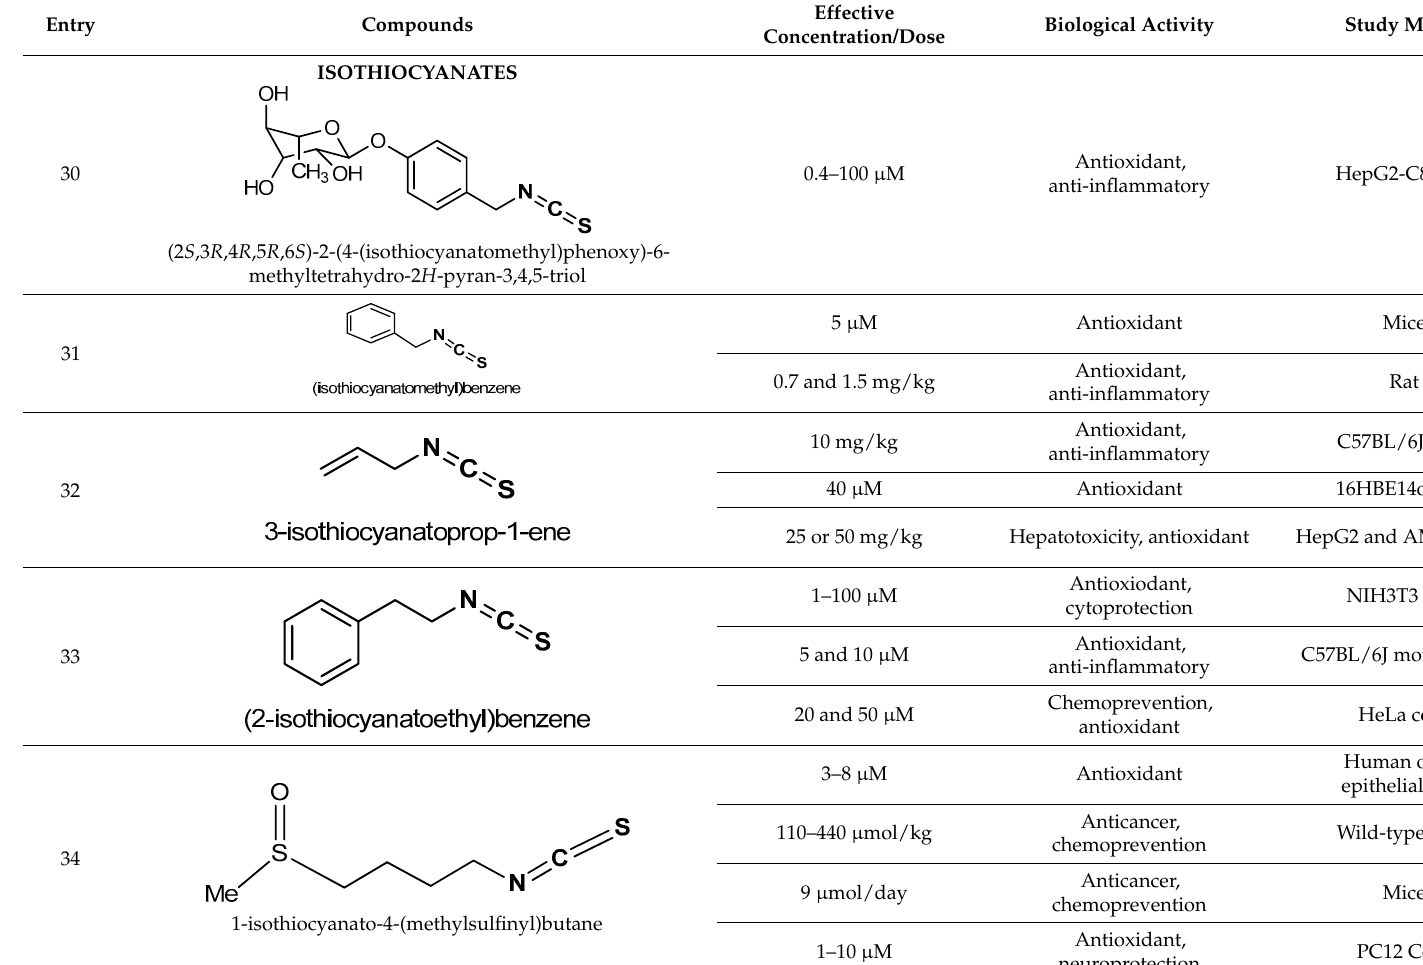
Table 2. Natural organosulfur compounds and their Nrf2 activation.